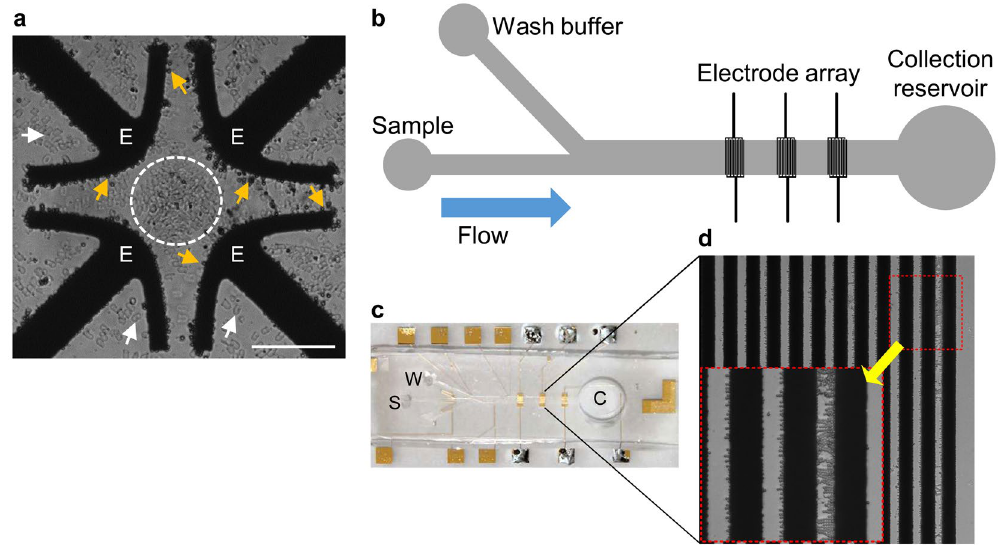
Figure 3. DEP trapping and characterization of polar capsules. ( a ) Light microscope image of a mixture of capsules and valves within a quadrupole electrode array chip, used for DEP characterization, at 10Vpp and 2 MHz. Note that the capsules (yellow arrows) are trapped (i.e. pDEP) on the edge of the electrodes (E), whereas valves (white dashed circle and white arrowheads) are repelled (i.e. nDEP) from the electrodes. Scale bar = 100 μ m. ( b ) Schematic description of the DEP-based microfluidic chip, which consists of a main channel with embedded electrode arrays. ( c ) A photo of the DEP-based chip, showing the sample loading (S), wash buffer (W) channels, and the collection reservoir (C). ( d ) Magnified view of the electrode array with trapped polar capsules. Inset (red box) shows magnified electrode and capsules. The entire separation process is shown in Supplementary Video